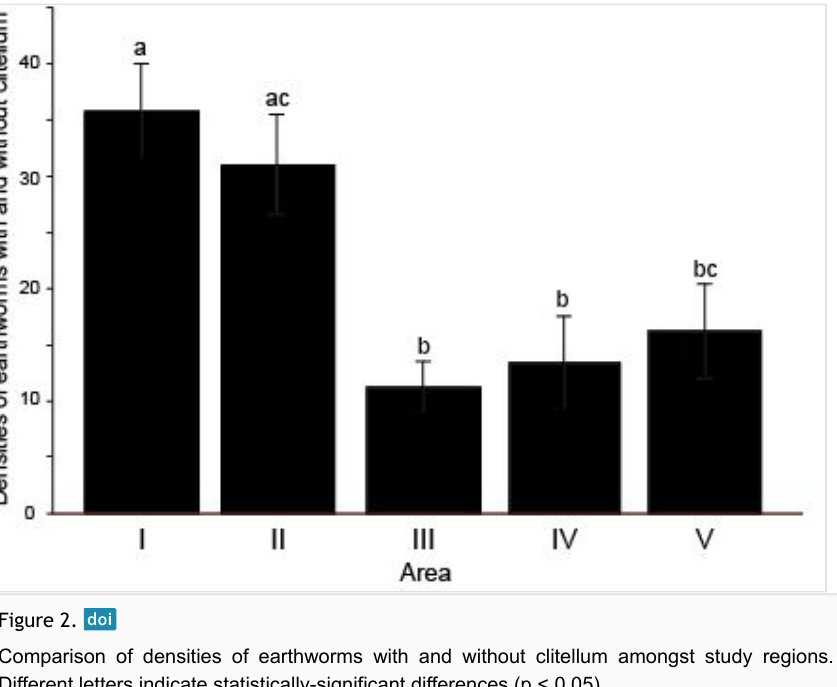
Figure 2. Comparison of densities of earthworms with and without clitellum amongst study regions. Different letters indicate statistically-significant differences (p <